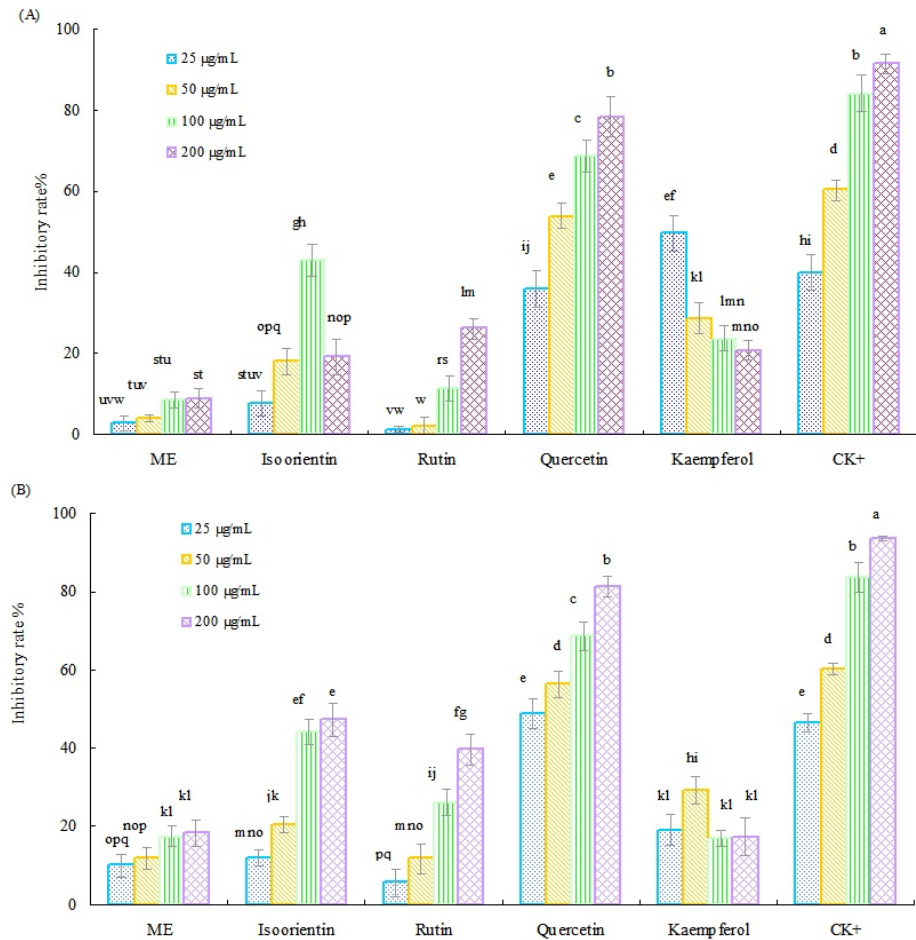
Figure 2. Inhibitory activity of ME of Tartary buckwheat sprouts and four flavonoids against the spore germination of F. oxysporum f. sp. vasinfectum ( A ) and F. oxysporum f. sp. cucumerinum ( B ). CK + was carbendazim. Different letters (i.e., a–q) in each column indicated significant differences among the treatment at p = 0.05 level.